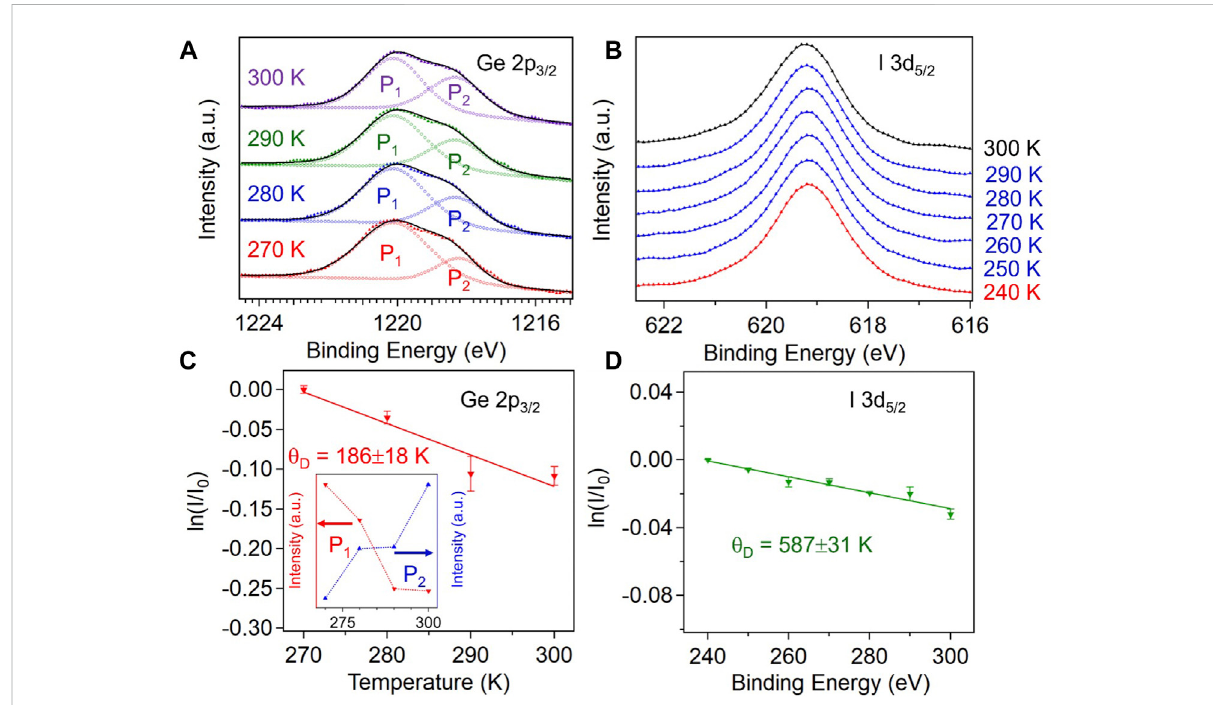
FIGURE 1 (A) RawXPSoftheGe2p 3/2 core-level(solidmarkers)collectedattemperaturesrangingfrom270 Kto300 K,alongwiththetotal fi t(blackline). The hollow markers show the P 1 and P 2 features. (B) XPS spectra of the I 3d 5/2 core-level recorded at temperatures ranging from 240 K to 300 K. (C) Debye – Waller factor plot for the P 1 feature of the Ge 2p 3/2 core-level, as well as the temperature dependence of the XPS intensities of the P 1 and P 2 components (inset). (D) Debye – Waller plot for the I 3d 5/2 core-level (Dhingra et al., 2022b). © IOP Publishing. Reproduced with permission. All rights